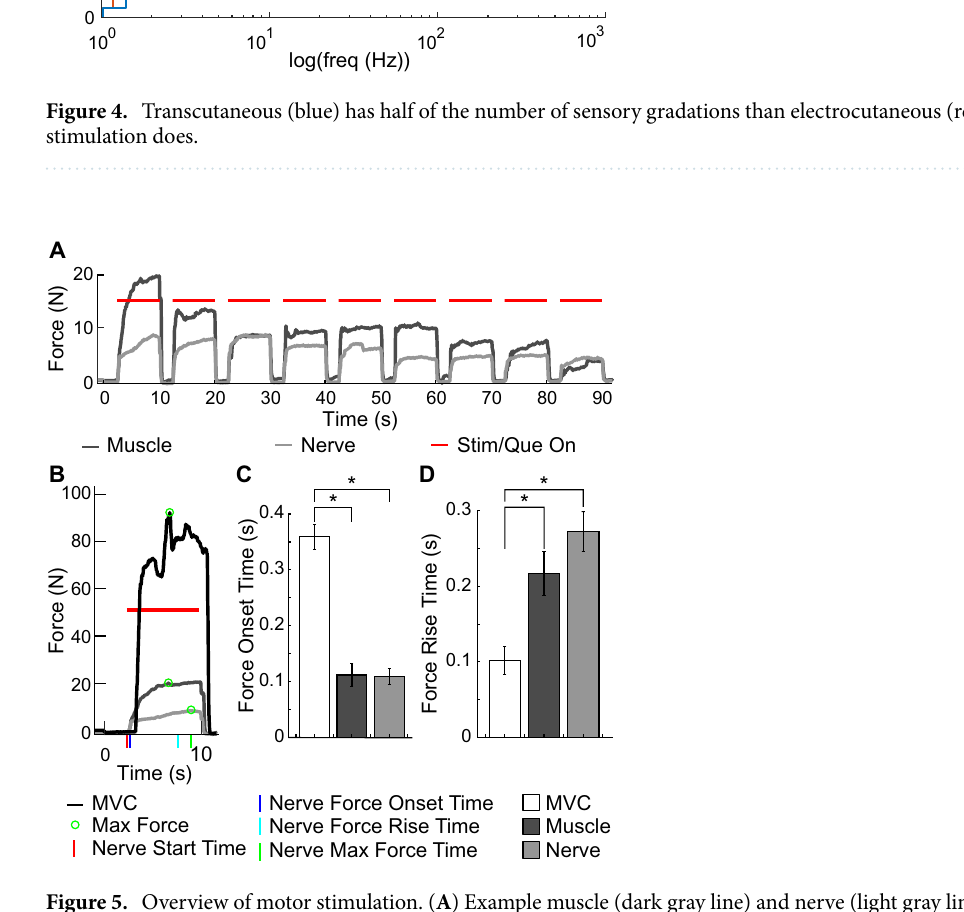
Figure 5. Overview of motor stimulation. ( A ) Example muscle (dark gray line) and nerve (light gray line) stimulation evoked grip force traces of a single participant. ( B ) A single trial with a corresponding maximum voluntary contraction (MVC) trace (black line). ( C ) Because of the participants’ response times to react to the stimuli, force onset time of MVC contractions (white bar; n = 70) was significantly slower than contractions evoked by muscle (dark gray bar; n = 69) and nerve (light gray bar; n = 64) stimulation ( p < 0.05, unpaired t-test). ( D ) MVC contractions (n = 64) demonstrated a significantly faster force rise time than muscle (n = 67) or nerve (n = 68) stimulation evoked contractions ( p < 0.05, unpaired t-test). No significant difference was found between the force onset time, or the force rise time of muscle and nerve stimulation evoked contractions. Bars show mean ± standard error of the mean. Asterisks denote statistical significance using the tests described